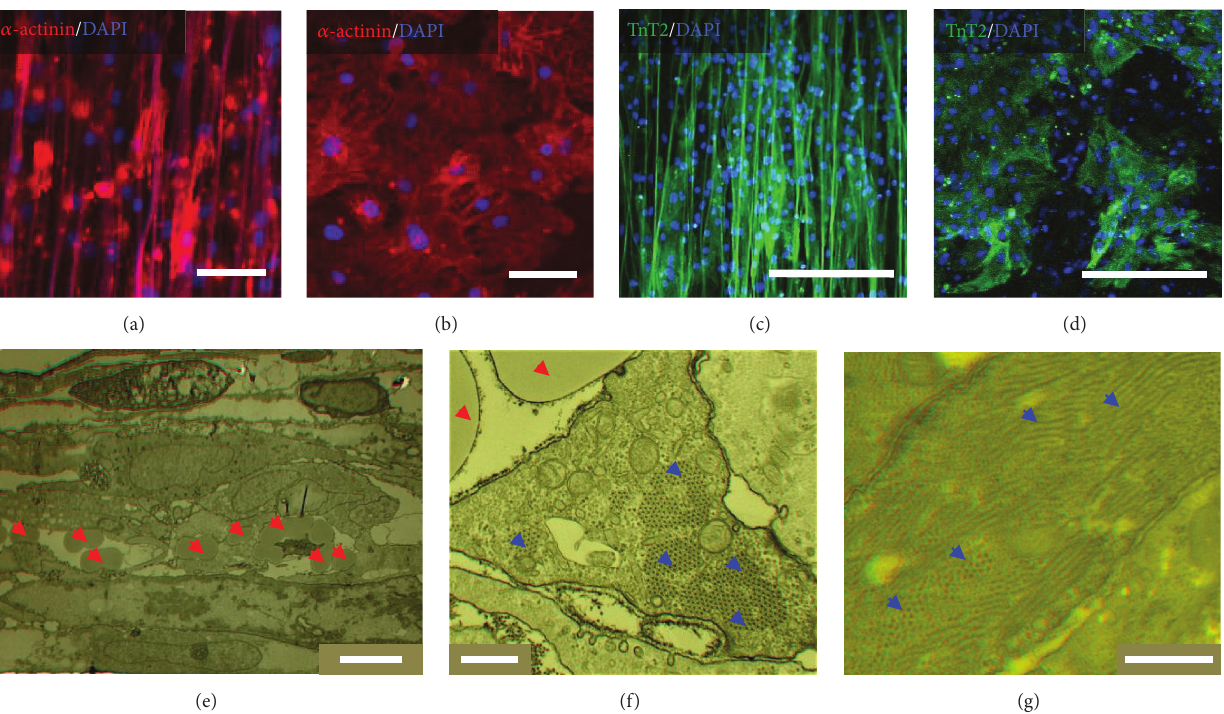
Figure 2: IMR hiPS-cardiomyocytes (CMs) on PMGI fibers. (a–d) Fluorescence image of CMs cultured for 14 days on aligned fibers (AFs) and gelatin-coated flat substrates (Flat). (a, b) 𝛼 -actinin is labeled in red and (c-d) TnT2 in green. The color on fiber is due to autofluorescence of PMGI. The scale bar in (a, b) = 50 𝜇 m. The scale bar in (c, d) = 200 𝜇 m. (e) Transmission electron microcopy images of CMs cultured for 14 days on AFs. The red arrows mark the fibers. The scale bar = 5 𝜇 m. (f, g) Higher magnitude TEM images of CMs cultured for 14 days on AFs (f) and Flat (g). The red and blue arrows mark the fibers and the sarcomeric bundles, respectively. The scale bar = 500